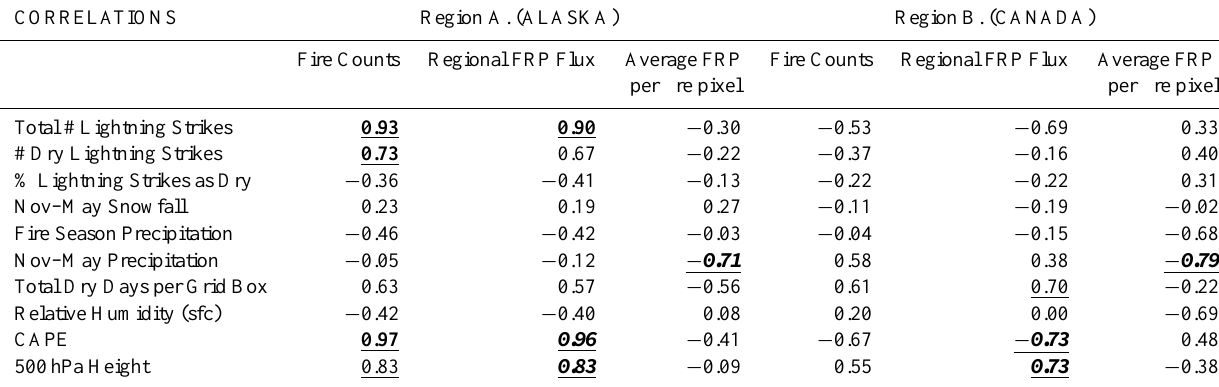
Table 3. Correlations for selected meteorological variables, fire counts, and FRP data 1 .